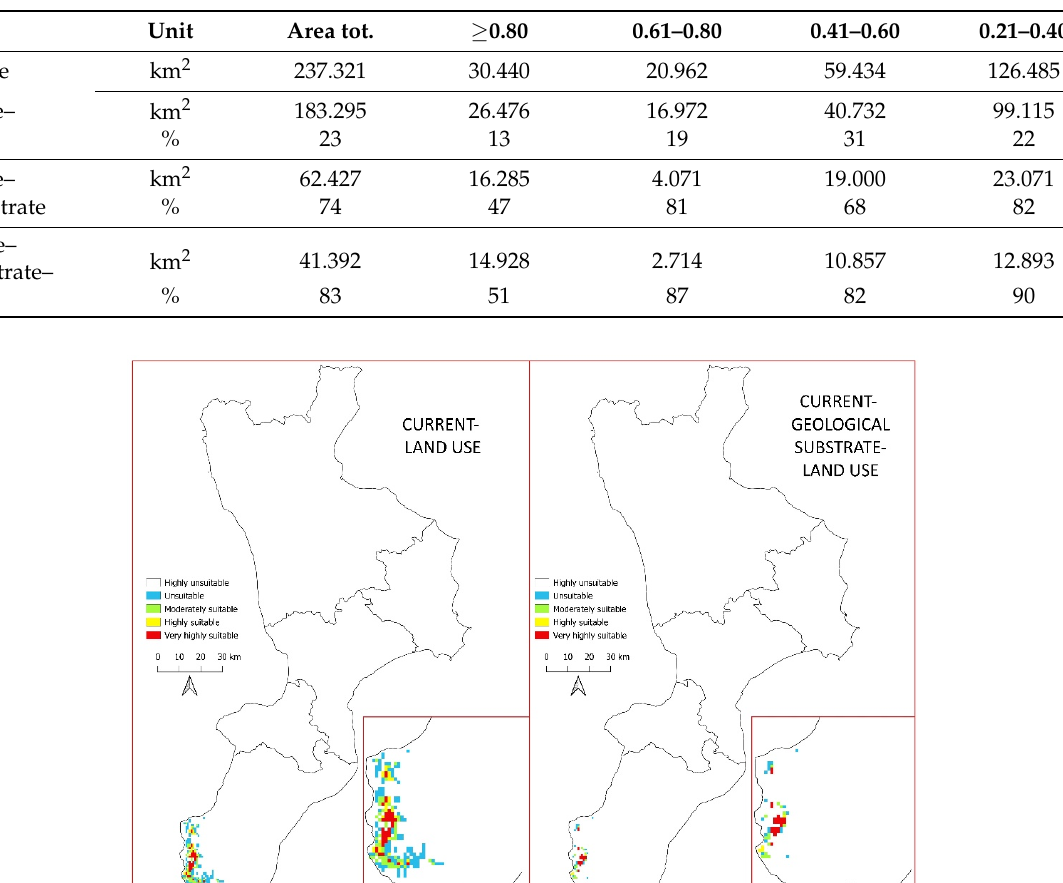
Figure 9. Prediction of the current potential distribution of Salvia ceratophylloides Ard. related to geological substrate, in two different scenarios SSP245 and SSP585 and two periods 2021–2040, 2041–2060. In white, highly unsuitable ( ≤ 0.20); in blue, unsuitable (0.21–0.40); in green, moderately suitable (0.41–0.60); in yellow, highly suitable (0.61–0.80); and in red, very highly suitable ( ≥ 0.80). Table 5. Ranking of habitat suitability of Salvia ceratophylloides Ard. Related to the values of probability of occurrence values in the different modelling obtained by interpolation with the current potential distribution. Very unsuitable ( ≤ 0.20); unsuitable (0.21–0.40); moderately suitable (0.41–0.60); very suitable (0.61–0.80); very suitable ( ≥ 0.80); and the area in km 2 and relative percentage (%) of decline compared to current potential modelling.